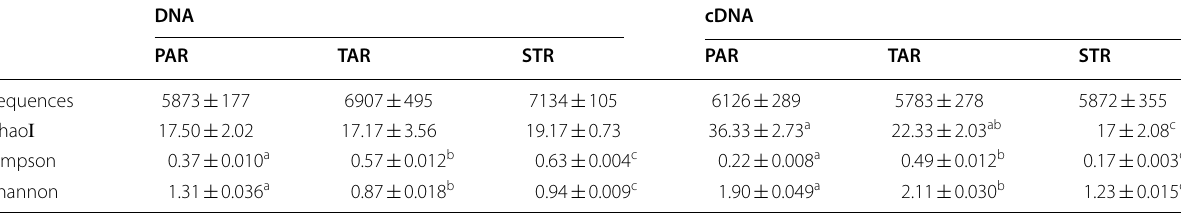
Values are means standard errors (n 3). Different letter (a, b or c) between different plant species within DNA or cDNA amplicon are significantly different (p < 0.05). ± = PAR, P. australis root; TAR, T. angustifolia root; STR, S. triqueter root